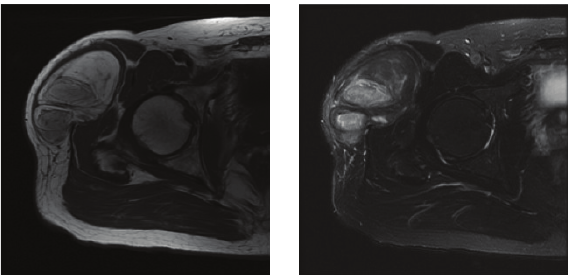
Figure 4: Axial T1 and T2 MRIs showing intralesional nodularity in a fatty tumor. Final pathological review confirmed a diagnosis of low-grade liposarcoma.